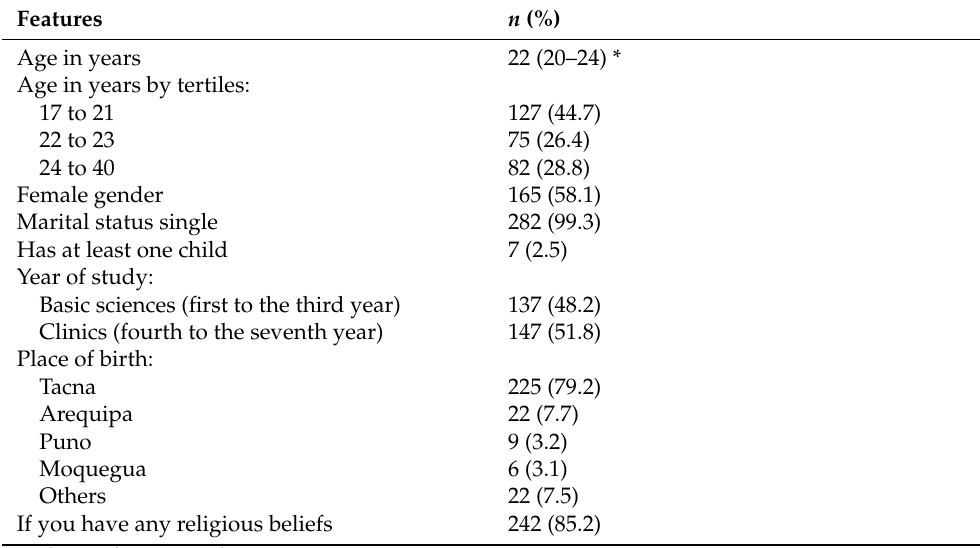
Table 1. Characteristics of participants ( n =